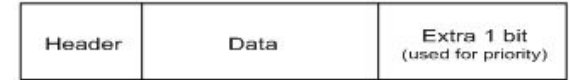
Fig. 3 Format of each data packet for proposed protocol I-XLP